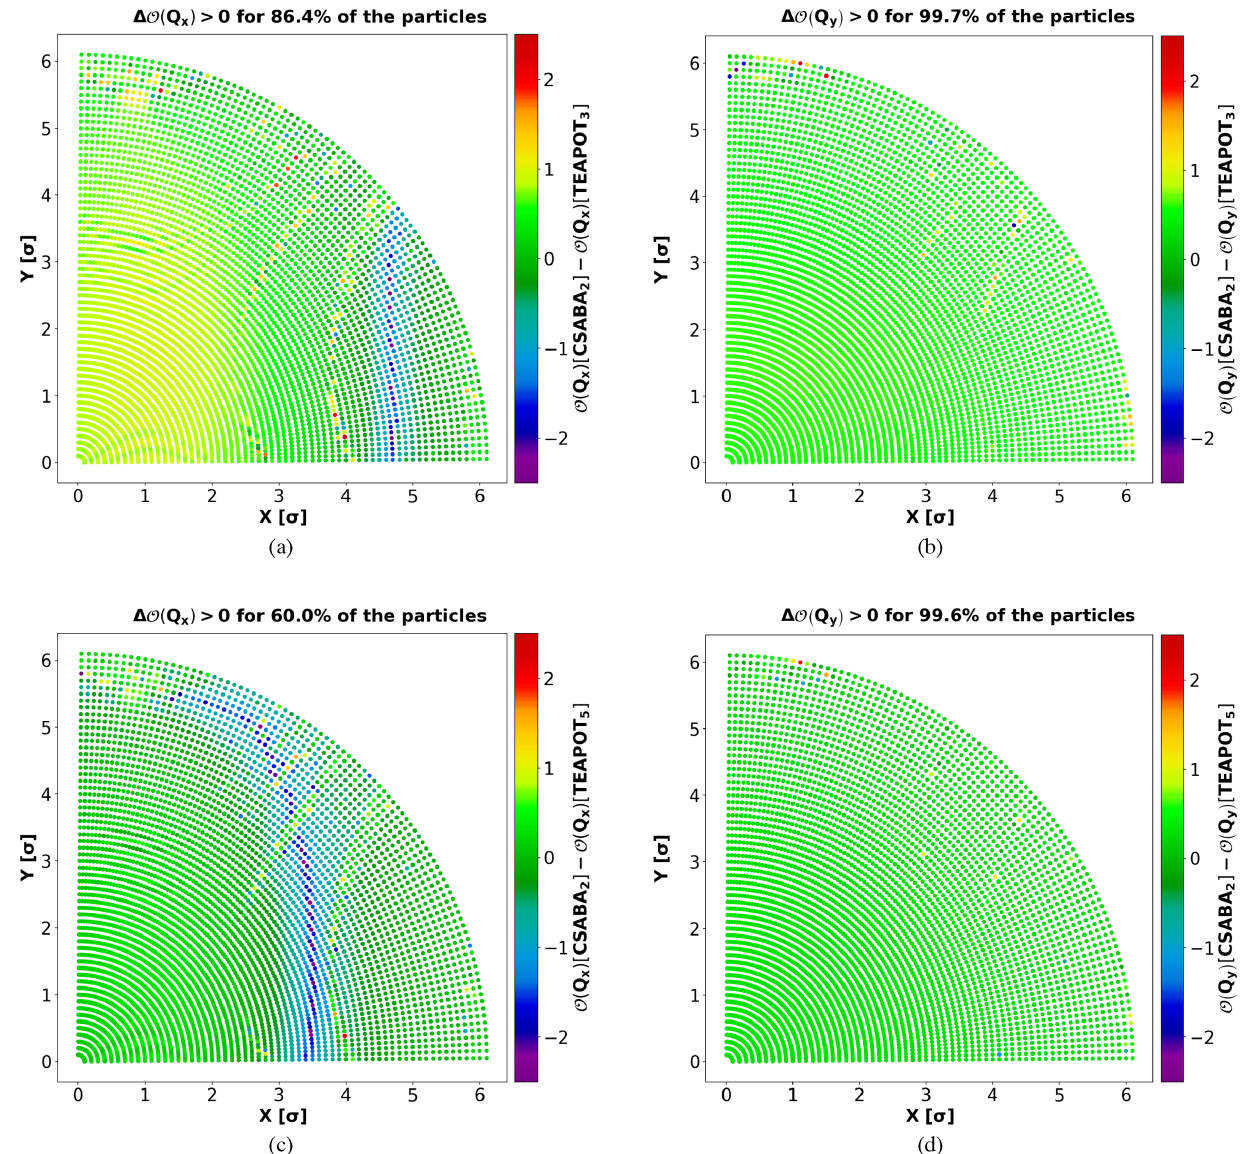
FIG. 7. The difference in order of accuracy of Q between (a) CSABA 2 & TEAPOT 3 and (c) CSABA 2 & TEAPOT 5 . The difference in x order of accuracy of Q between (b) CSABA 2 & TEAPOT 3 and (d) CSABA 2 & TEAPOT 5 y